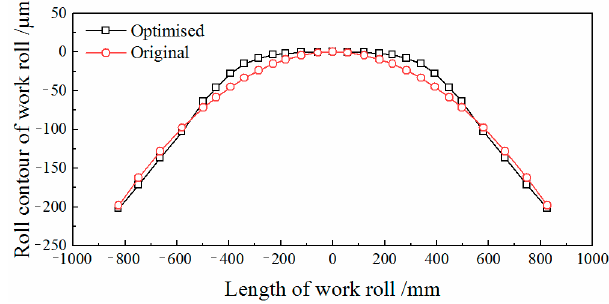
Figure 23. Roll contours before and after optimisation.